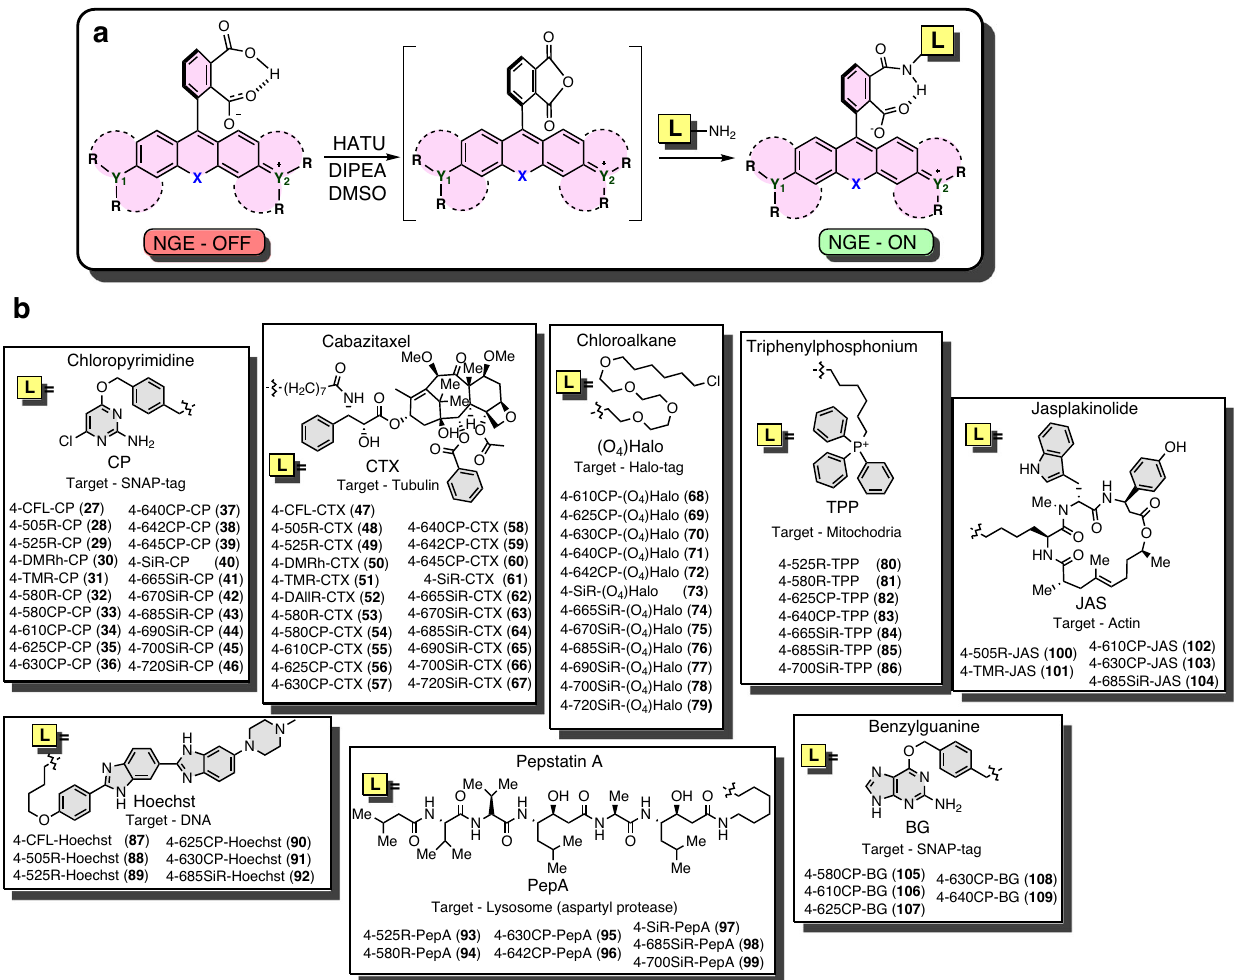
Fig. 3 | Synthesis of a library of STED imaging-compatible fl uorescent probes targeting different intracellular targets. a General conjugation reaction scheme. b Structures of the synthesized